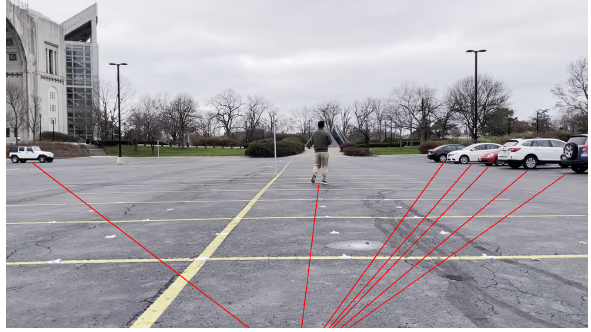
Figure 1. An example image acquired from a monocular camera mounted on a vehicle showing the road from the vehicle’s perspective. Red lines indicate projective physical distance of embedded camera and objects. Each red line has two ending points. One is from camera outside the image. The other is located from the object pixel coordinate. DLT utilized relationships between points in projective coordinates and geometry